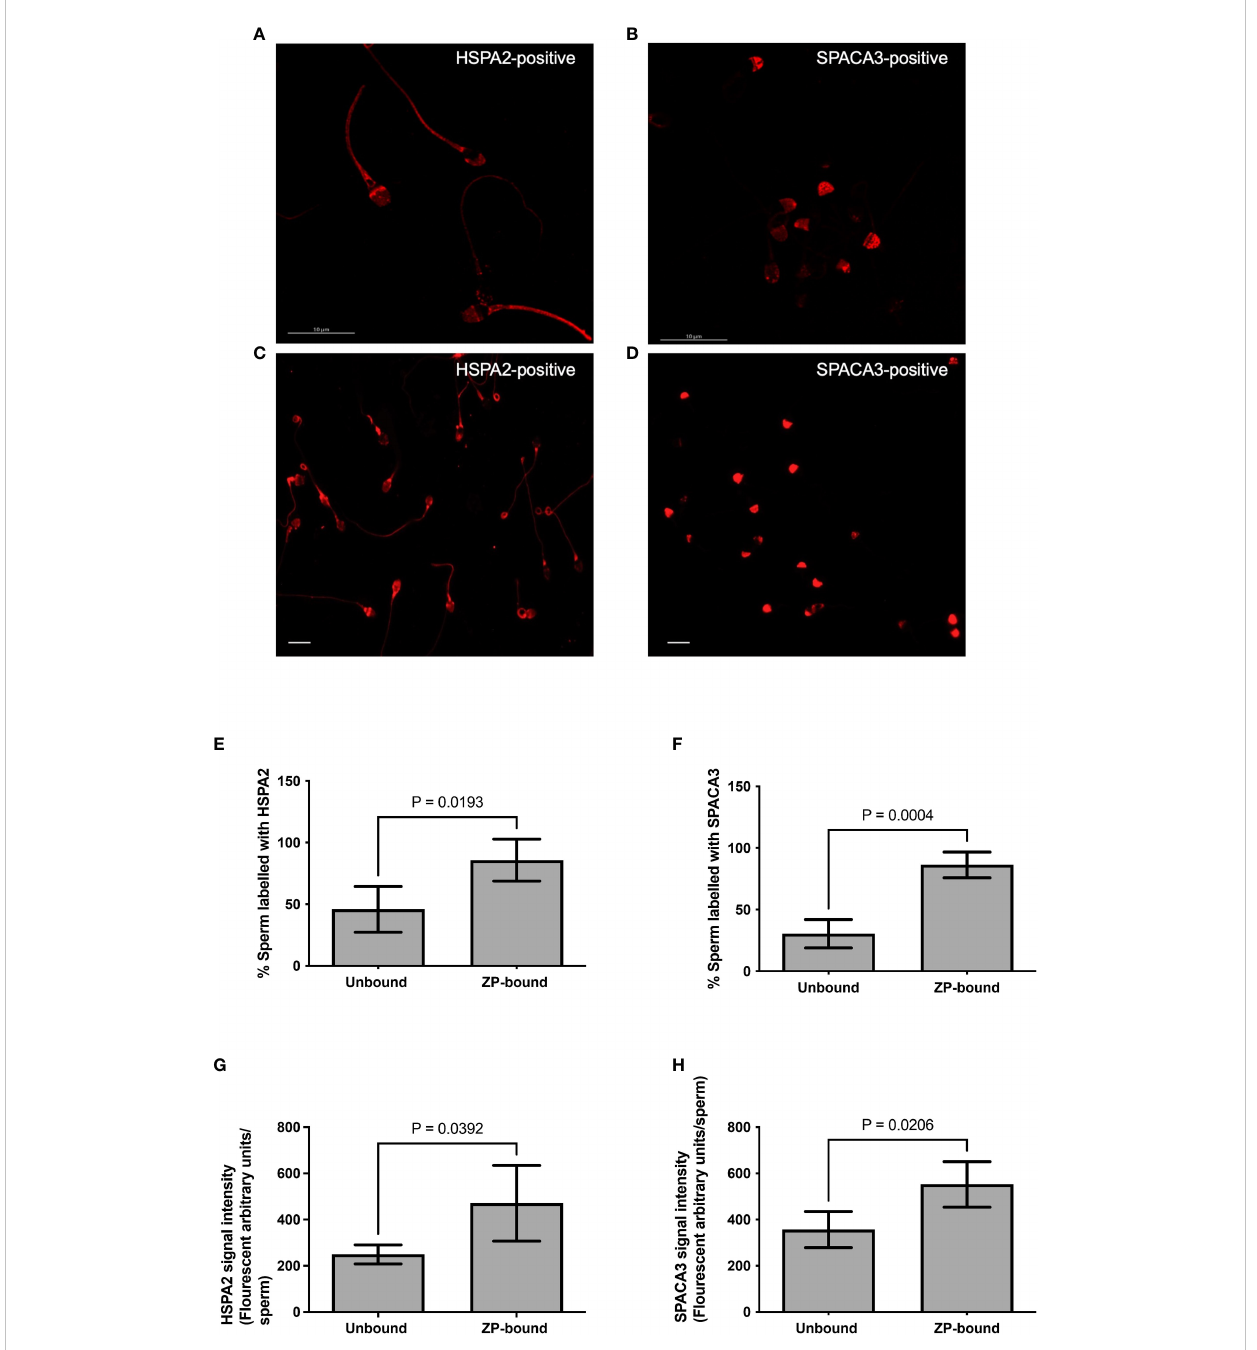
FIGURE 3 Immunolocalization of HSPA2 and SPACA3 on capacitated human spermatozoa. (A, B) Capacitated spermatozoa were labelled with anti-HSPA2 and SPACA3 antibodies (diluted 1:100) respectively followed by Alexa-555 secondary antibodies. The images captured using confocal microscopy showed granular staining patterns of HSPA2 and SPACA3 on spermatozoa. Scale bar = 10 m M. (C) HSPA2 was localized to the peri-acrosomal region, equatorial segment, post-acrosomal region, mid-piece and the sperm tail. (D) SPACA3 was localized to the acrosomal region. Scale bar=200 uM. (E, F ) Quanti fi cation of ZP-bound recovered at 30 min and unbound spermatozoa showing positive staining with HSPA2 and SPACA3 at the head regions. All data are represented as mean ± SD (n=4, p<0.05). (G, H) Fluorescence intensity analysis of each protein marker was performed by the Image J software. All data are represented as mean ± SD (n=4,